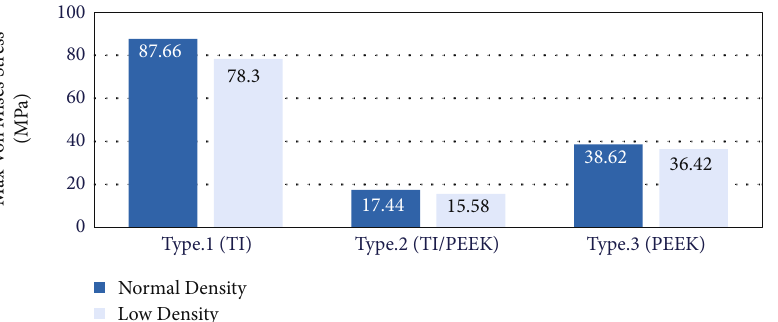
Figure 3: Maximum von Mises stresses (MPa) on the framework.